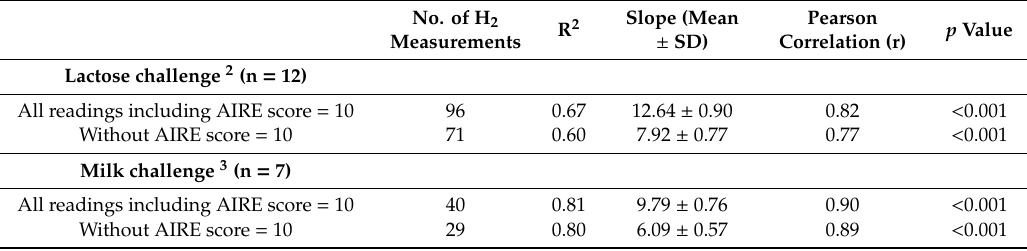
Table 1. Linear regression analyses for the association of breath H 2 measurement using AIRE and BreathTracker 1 .